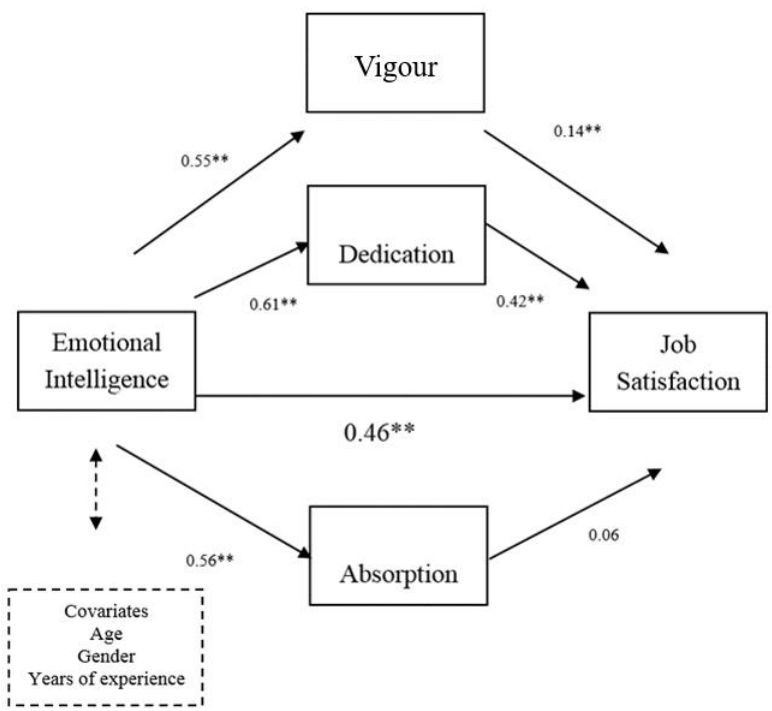
Figure 2. Multiple mediation model of the work engagement dimensions explaining the relationship between emotional intelligence and job satisfaction. ** p < 0.01.